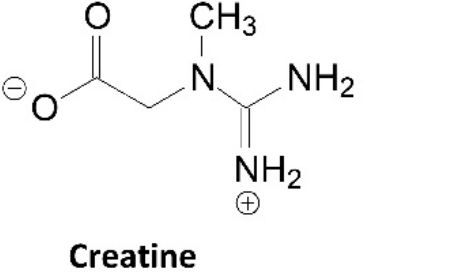
Figure 8. Chemical structure of creatine and creatine ethyl ester.